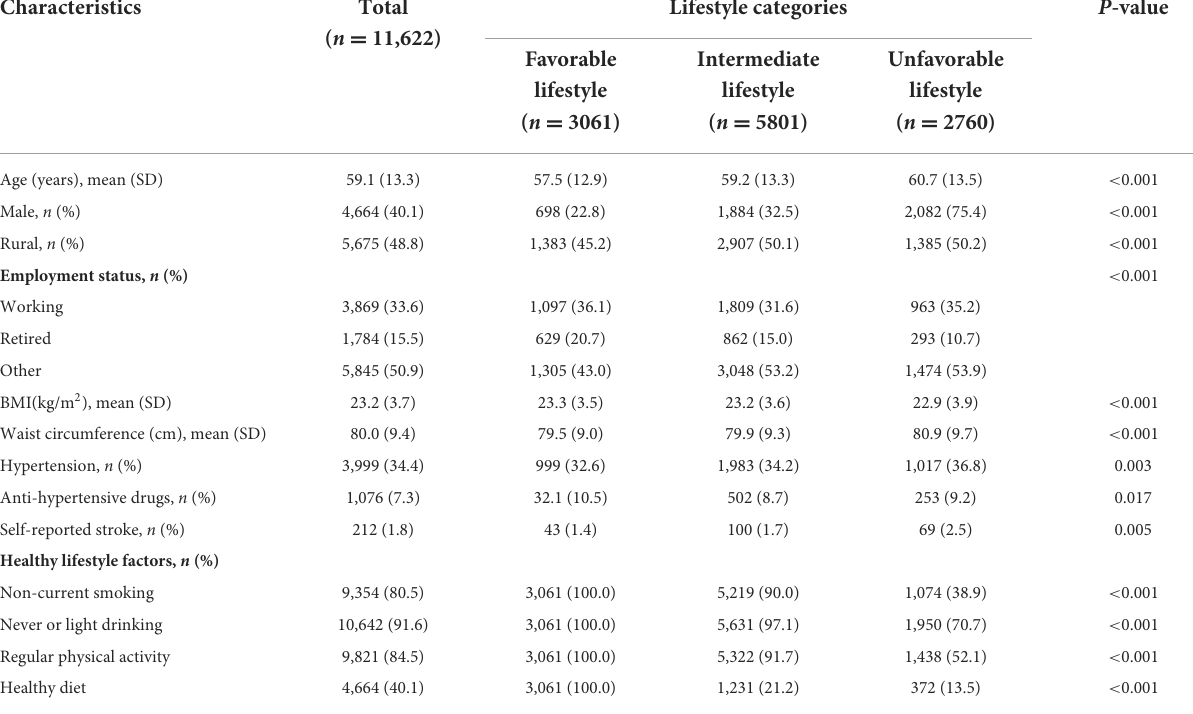
TABLE 1 Baseline characteristics of all participants stratified by categories of lifestyle factors.